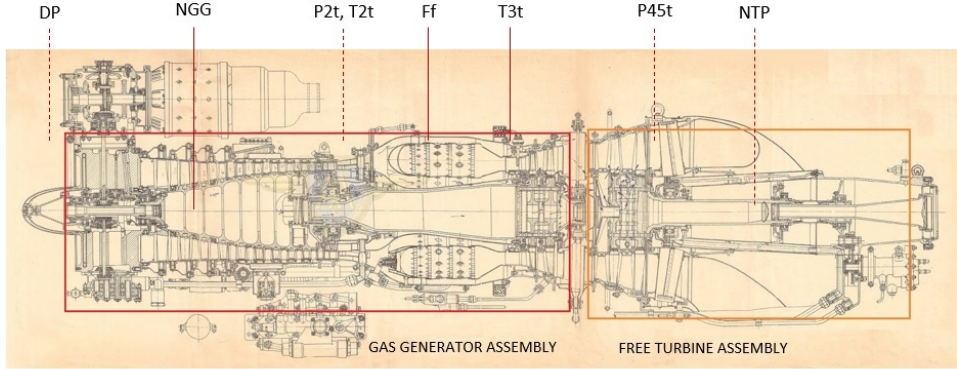
Figure 3. TV2-117A engine stations and instrumented parameters.